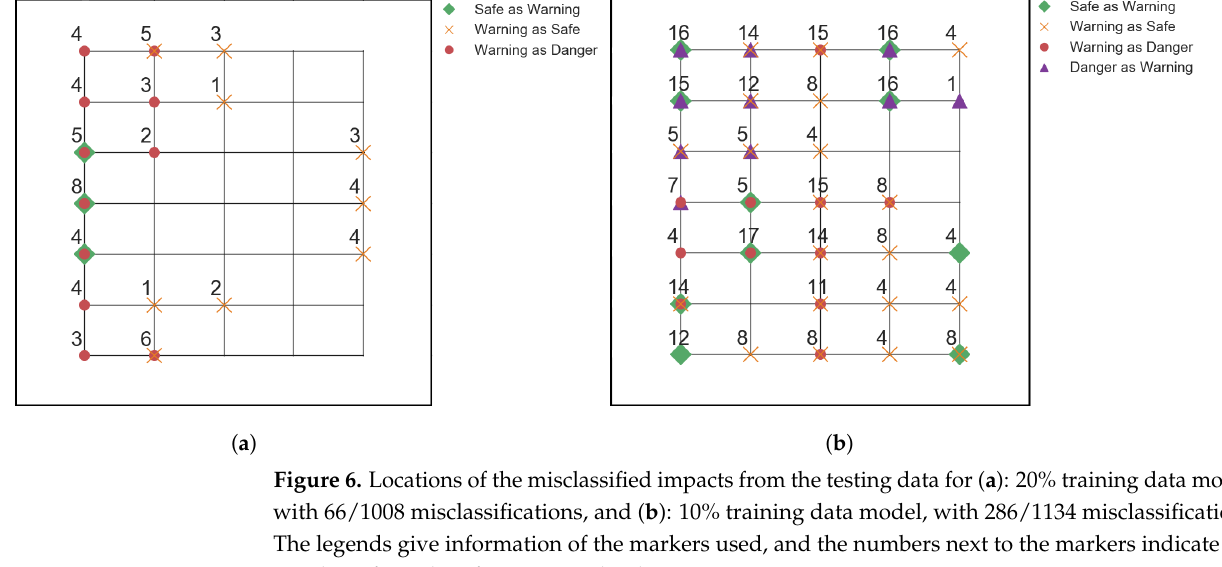
Figure 6. Locations of the misclassified impacts from the testing data for ( a ): 20% training data model, with 66/1008 misclassifications, and ( b ): 10% training data model, with 286/1134 misclassifications. The legends give information of the markers used, and the numbers next to the markers indicate the number of misclassifications on that